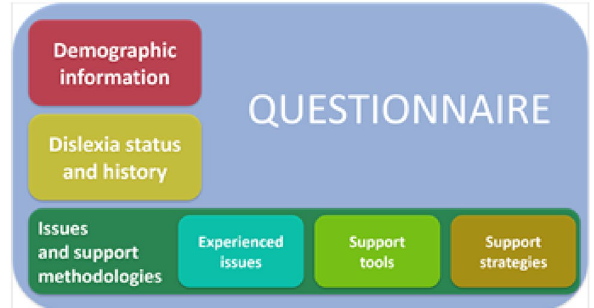
Figure 1. Scheme of the questionnaire administered to dyslexic